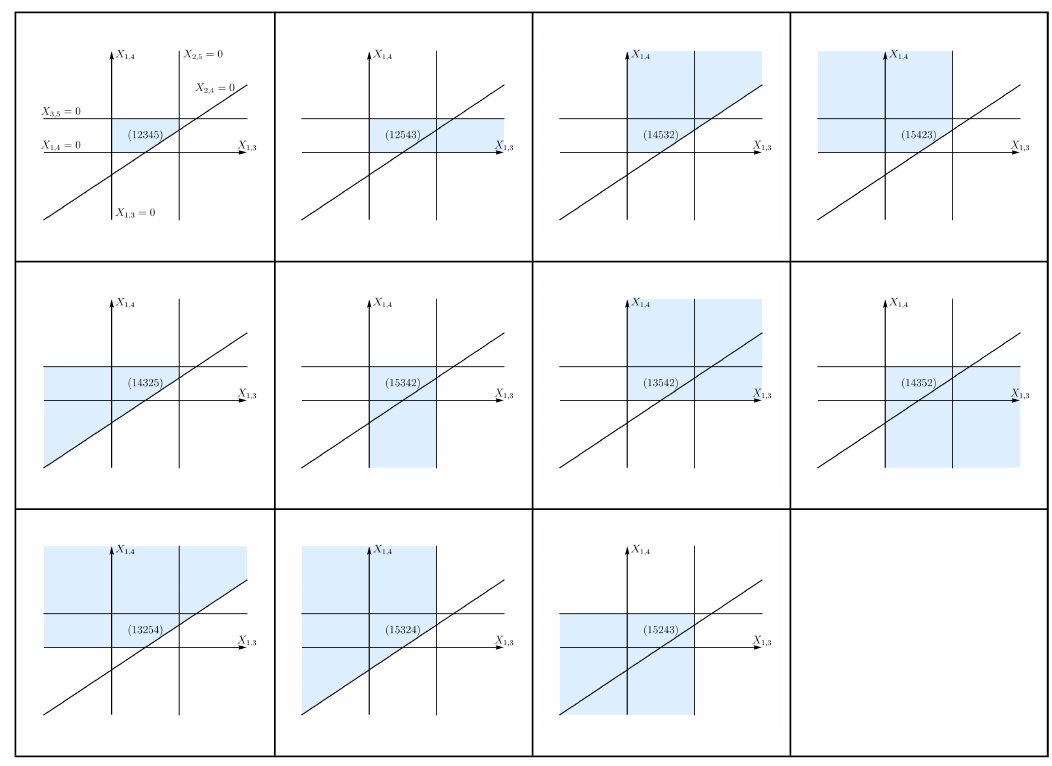
Figure 17 . Associahedra for n = 5 . The depicted geometries are all oriented counter-clockwise.